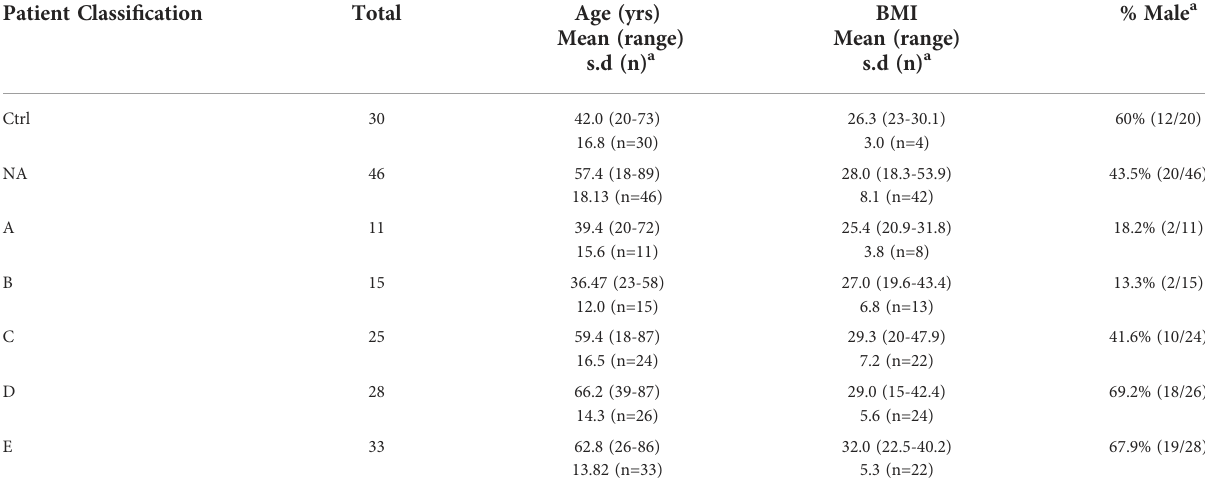
TABLE 2 Demographic data for patients enrolled in baseline measurement study. Patient Classi fi